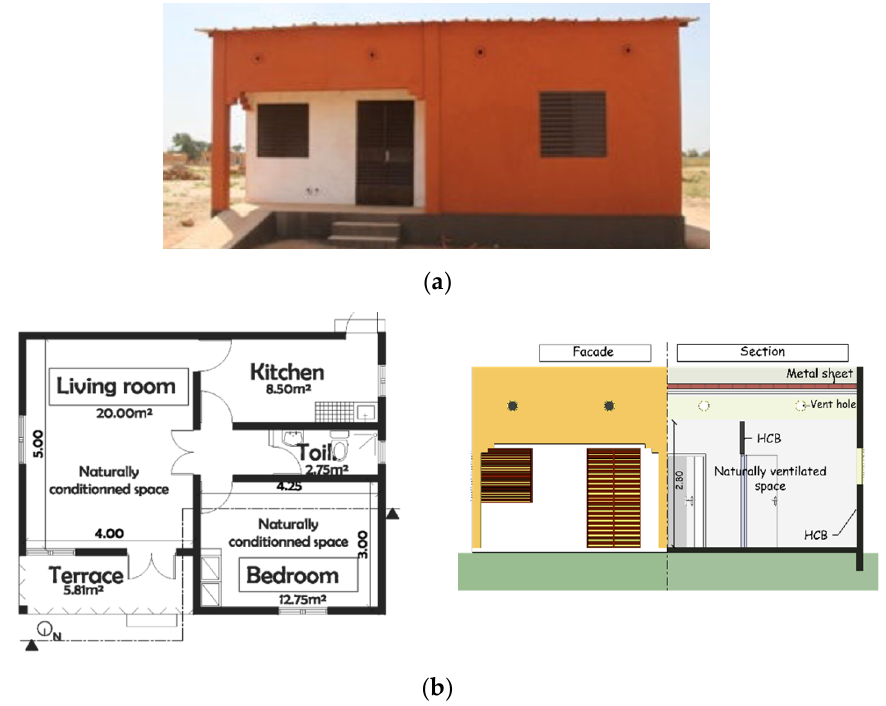
Figure 1. Modest and classical urban housing in Ouagadougou: ( a ) picture of the main façade, ( b ) plan and section view.